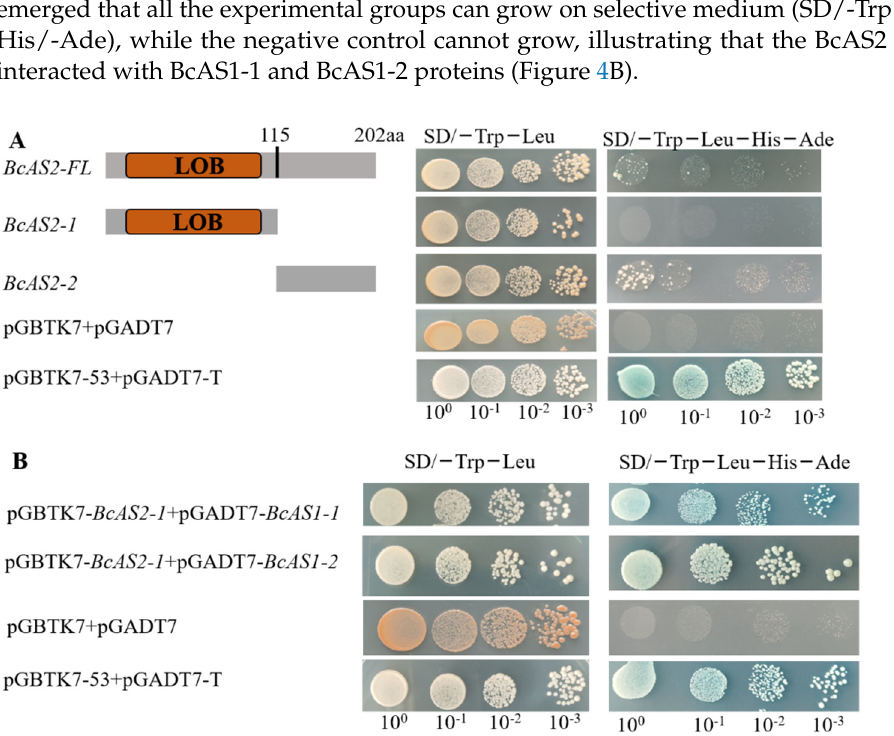
Figure 4. Validation of interaction between BcAS2 and BcAS1-1/2 in vivo. ( A ) Transactivation activin analysis of BcAS2 . BcAS2 -FL, BcAS2 -1 and BcAS2 -2 represented the full-length, the region containing Lateral Organization Boundary (LOB) domains and the rest region of BcAS2, respectively, which were cloned into pGBTK7 (BD) and co-transformed into Y2H gold strains with pGADT7 (AD). ( B ) Interaction validation of BcAS1 -1/2 (two homologous genes of AS1 gene in pak choi) and BcAS2 , pGADT7 + pGBKT7 and pGADT7-T + pGBKT7-53 were used as the negative and positive